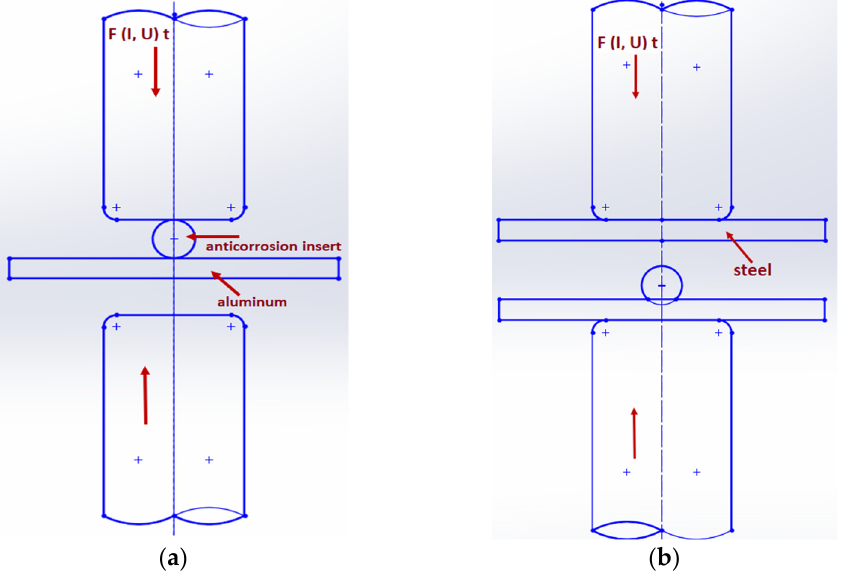
Figure 2. Schematic representation of joint formation by resistance spot welding: ( a ) welding of insert element to aluminum and ( b ) welding of steel plate to insert–aluminum joint. Table 4. Spot resistance welding